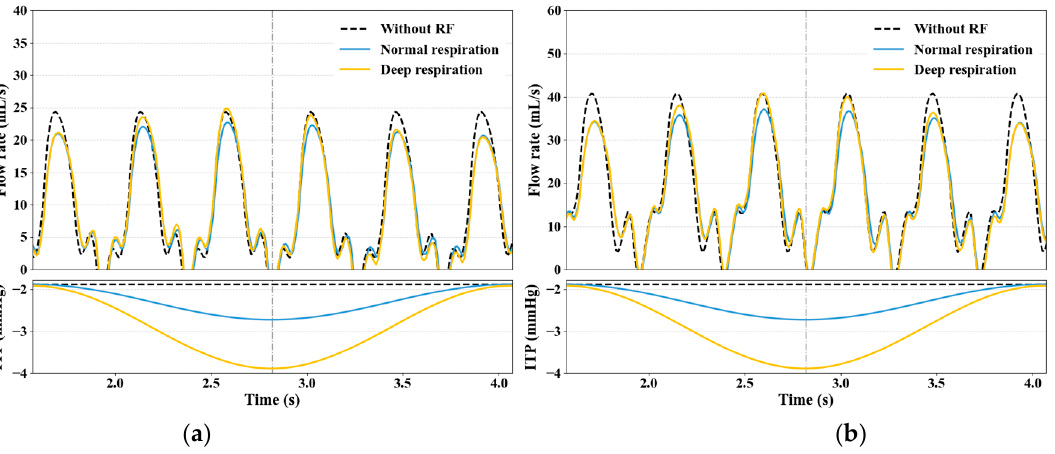
Figure 8. Flow rates and ITPs in SVC ( a ) and IVC ( b ) of an infant subject in normal and deep breathing modes and without RF effect.